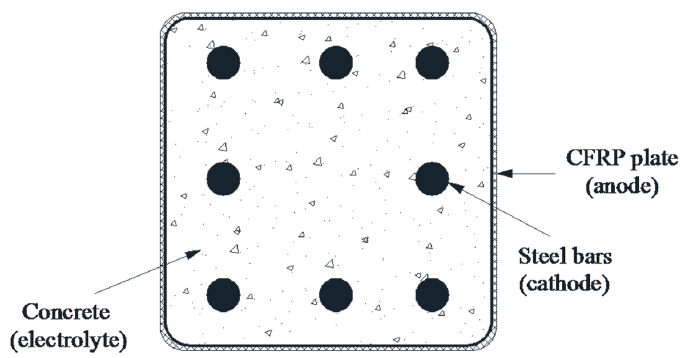
Figure 8. A typical reinforced concrete section with eight steel rebars and an exterior CFRP plate wrapped as an anode.